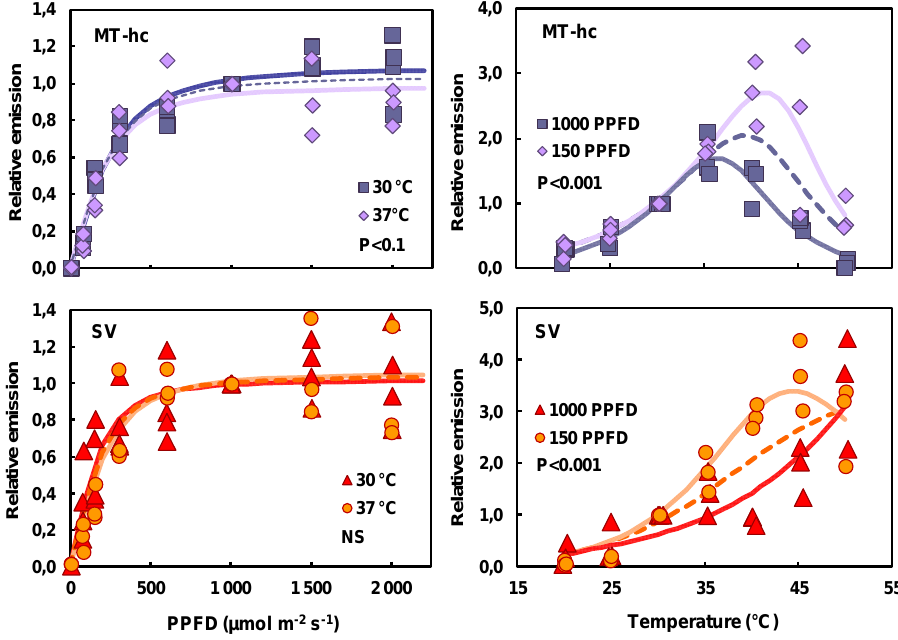
Fig. 3. Light (left) and temperature (right) responses of MT-hc (upper panels) and SV emissions (lower panels) of Q. coccifera leaves determined at two different temperature levels (30 and 37 ◦ C) and two light levels (150 and 1000µmolm − 2 s − 1 PPFD). Emis- sion data of each temperature and light response were normalised to respectively 30 ◦ C and 1000µmolm − 2 s − 1 PPFD. Curves are sim- ulations obtained by curve fitting using the temperature and light equations described in M&M (see Eqs. 1 and 2) either on individ- ual data sets (straight lines) or combined data sets (dotted lines). P-values annotate the statistical probability individual fits are dif- ferent from global fits (NS: Not Significant). The deduced coefficients are as follows: Light responses: MT-hc 30 ◦ C: α